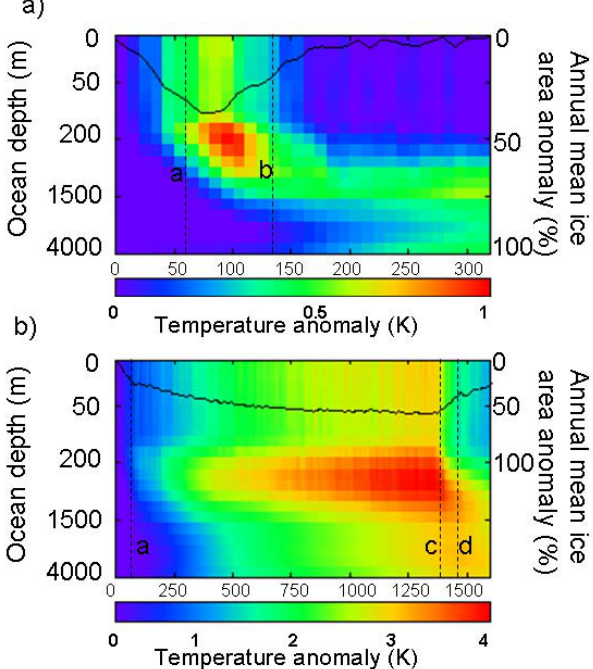
Figure 5. The Southern Ocean potential temperature anomaly, as a function of ocean depth (averaged between 75ºS and 55ºS), in simulated time (years) for the fast scenario (top) and the slow scenario (bottom). The x-axis is simulation years. At the top is the change in the associated anomaly in Antarctic sea ice area. Note that the ocean depth axis has is a non-linear scale. Labels are as depicted in figure 1.